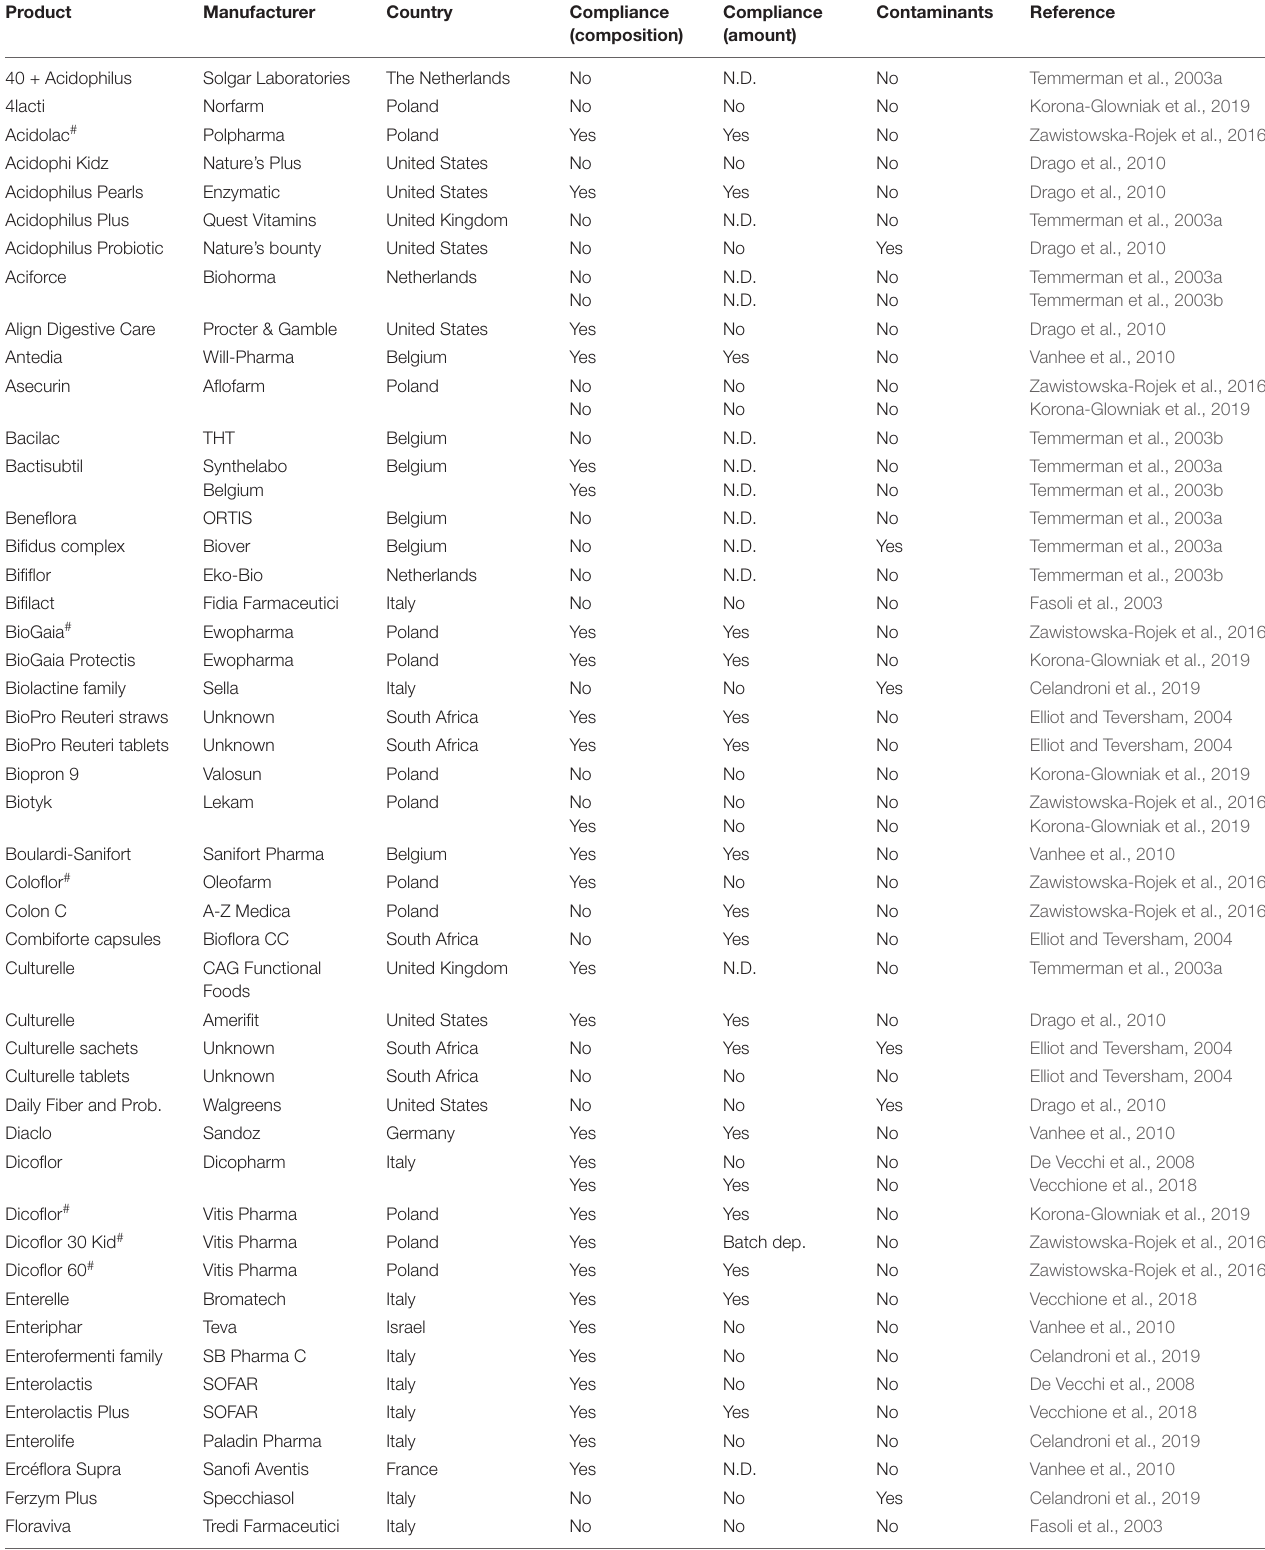
TABLE 2 | Compliance with the label claims of probiotic dietary supplements marketed worldwide: focus on the microbial composition, amount of living cells, and presence of contaminant microorganisms.